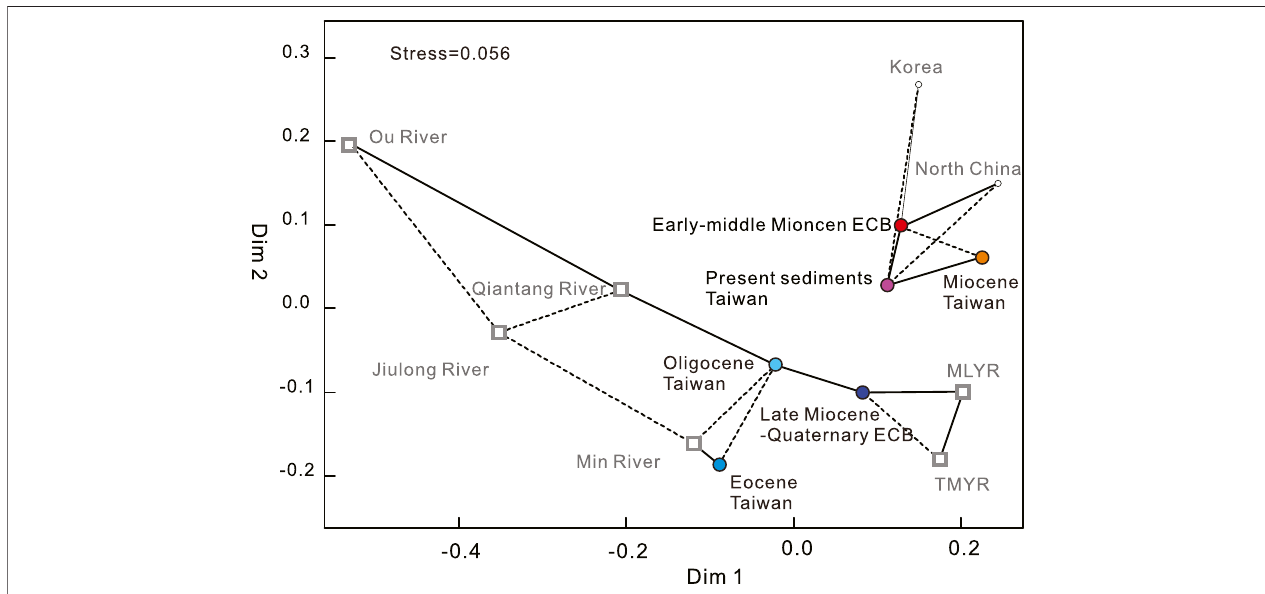
FIGURE 3 | Non-metric multidimensional scaling (MDS, Vermeesch et al., 2016) plot of detrital zircon data. See Table 1 for source of literature data.